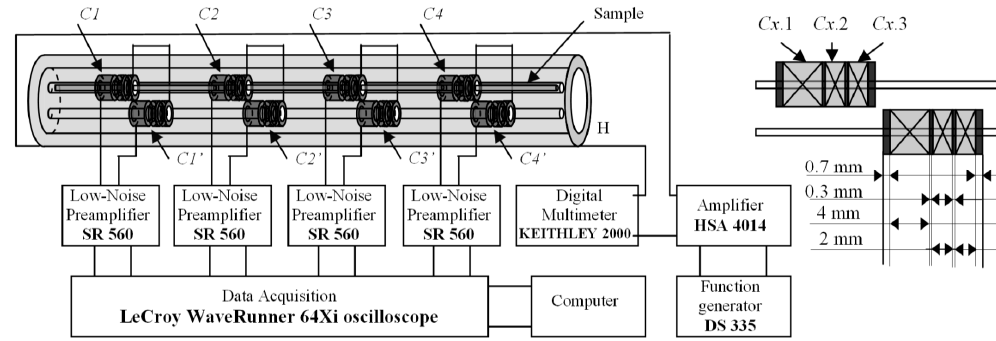
Figure 3. Schematic of the improved system employed for domain wall velocity measurements in amorphous glass-coated nanowires and submicron wires prepared by means of glass-coated melt